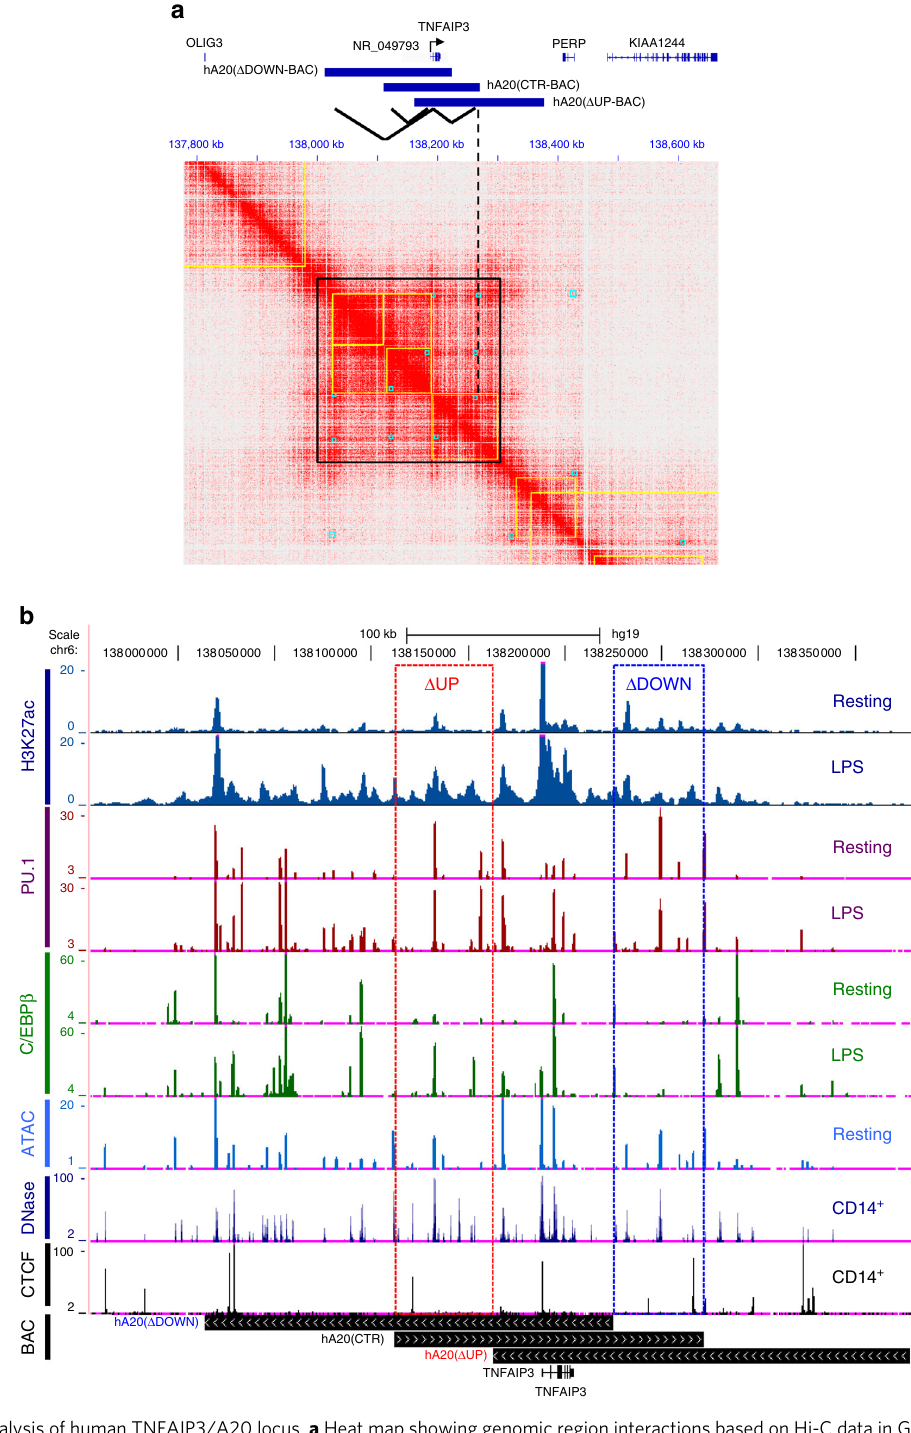
Fig. 1 Epigenomic analysis of human TNFAIP3/A20 locus. a Heat map showing genomic region interactions based on Hi-C data in GM12878 B cells. Yellow boxes indicate topologically associating (sub) domains and blue boxes, interaction anchors. Dashed line shows downstream anchor relative to BAC locations. b Gene track showing chromatin accessibility (ATAC-seq, DNase) or H3K27-Ac, PU.1, C/EBP, and CTCF ChIP-seq read counts in primary human monocytes stimulated − /+LPS for 3 h. Genomic locations of BACs used in this study are shown. Data are representative of two replicates or derived